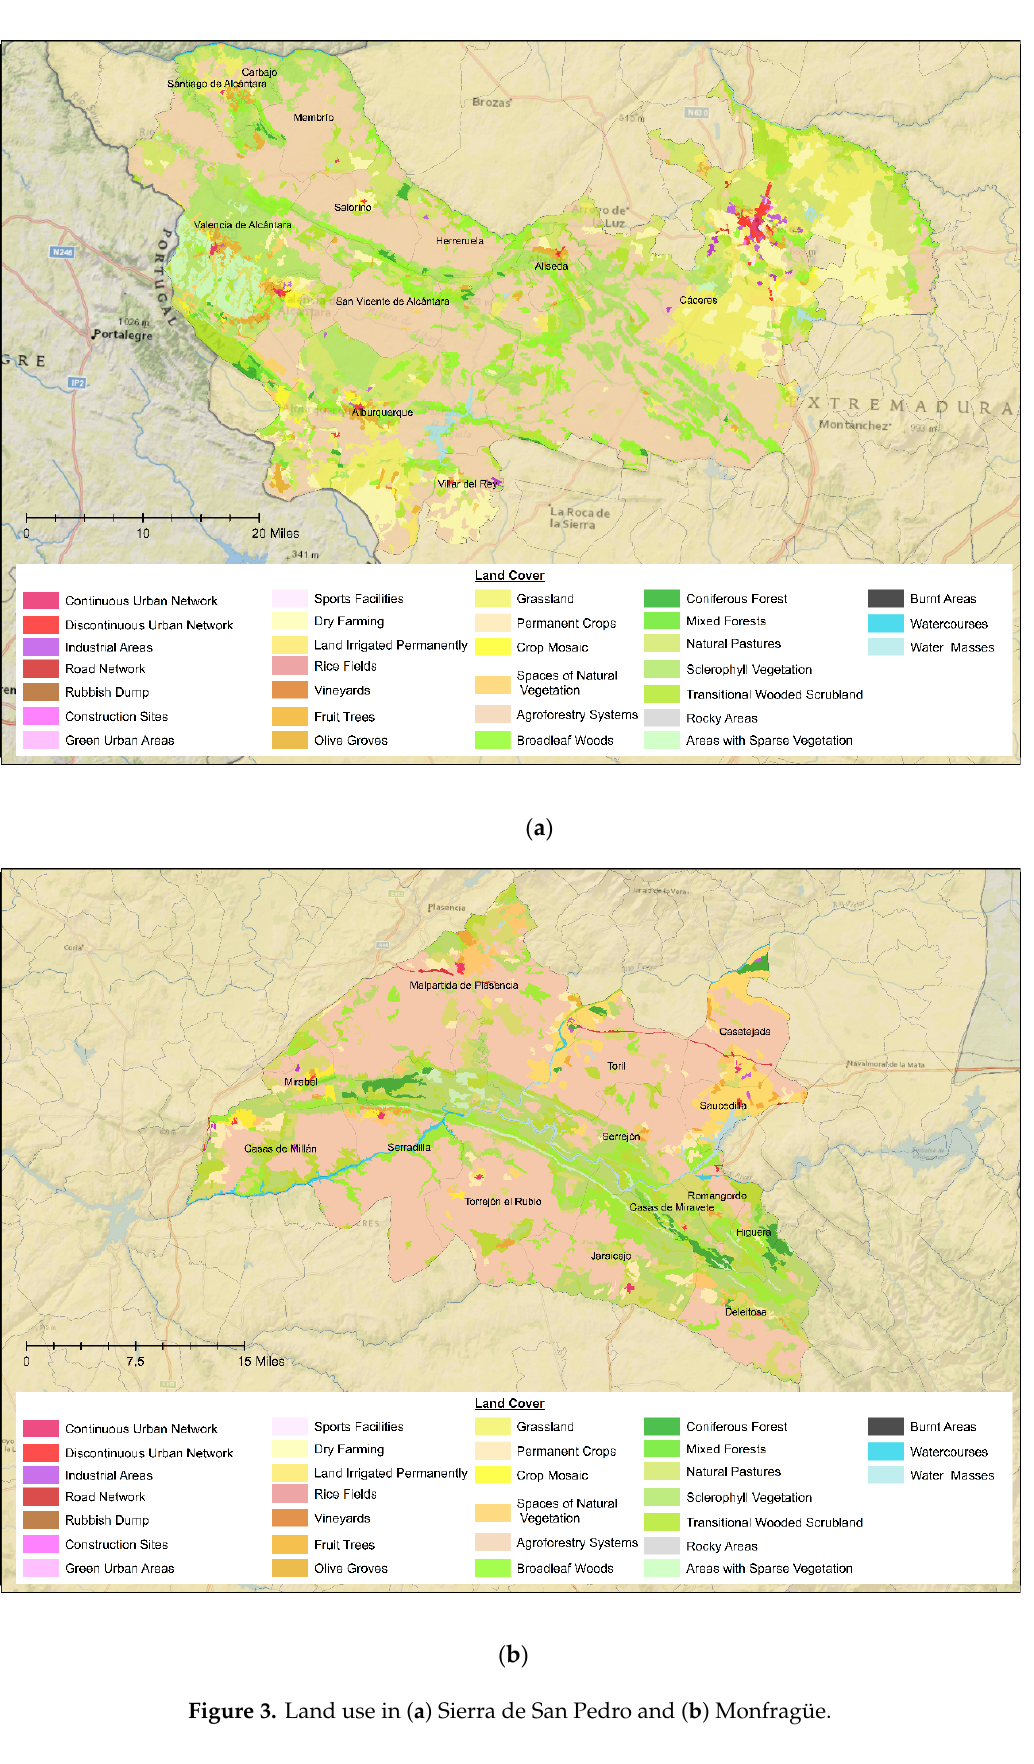
Figure 3. Land use in ( a ) Sierra de San Pedro and ( b ) Monfragüe.